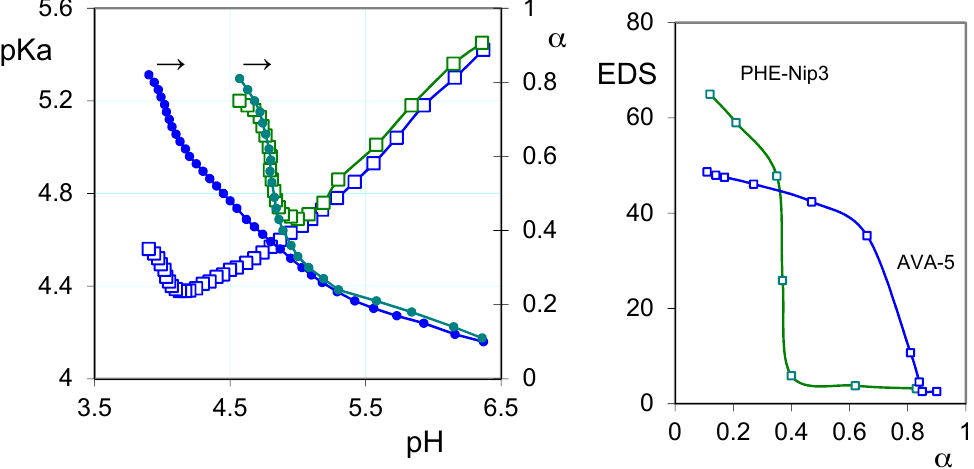
Figure 1. ( Left ) Relationships between the acidity constants (pKa, open squares), degree of protonation ( α , filled circles) and pH of the hydrogels PHE-Nip3 (green line) and AVA-5 (blue line); ( Right ) The equilibrium degree of swelling (EDS) in relation to α for the hydrogel PHE-Nip3 (green line) and AVA-5 (blue line) (all data are referred to 25 °C and 0.15 M NaCl).